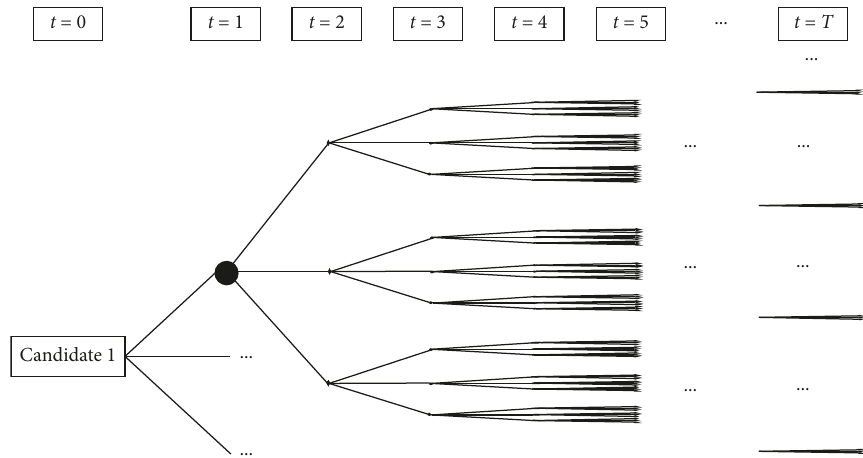
Figure 2: Original multistage scenario tree (random inflows of candidate 1).